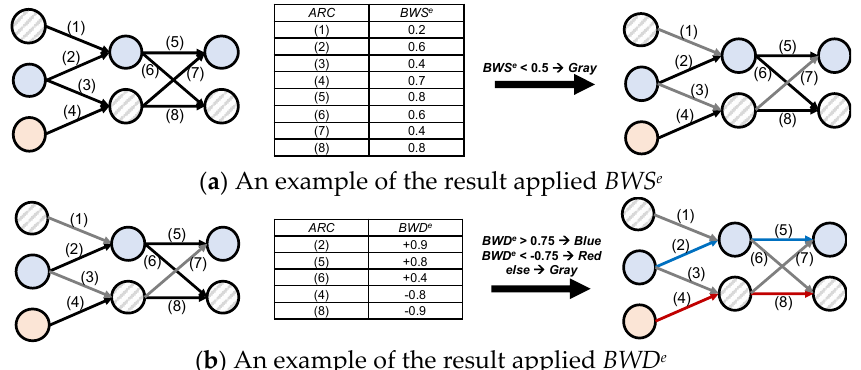
Figure 8. An example of the model that applied the arc color-coding.